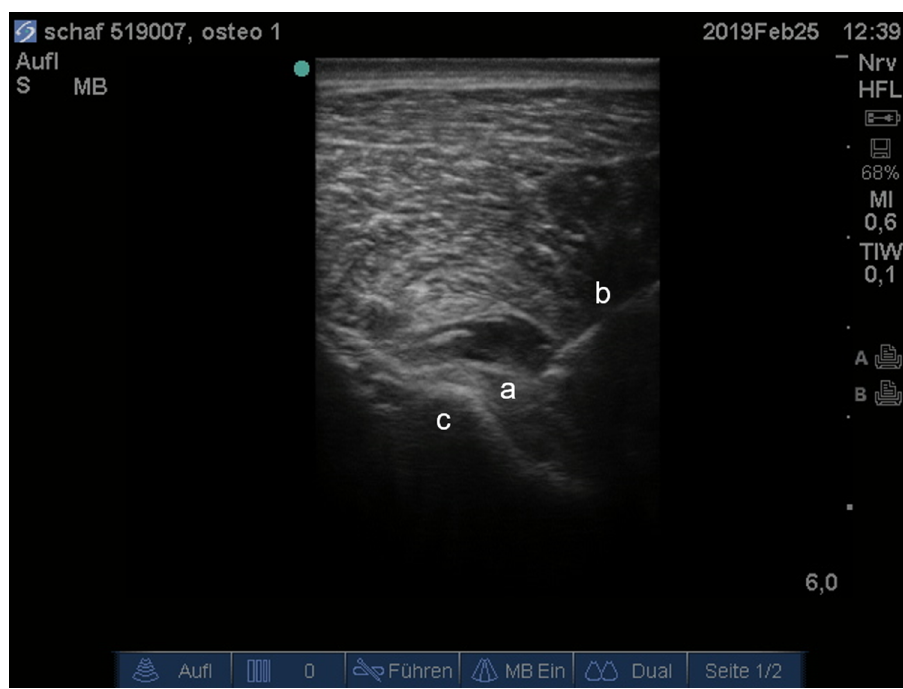
Figure 1. Ultrasonographic image of the right sciatic nerve (a), needle (b), ilium (c). For the third injection, the sheep was placed in lateral recumbency with the limb to be operated uppermost. After sonographic visualization of the femoral nerve and the injection needle the last injection was performed (Figure 2). The person performing the injections was unaware of the content of the